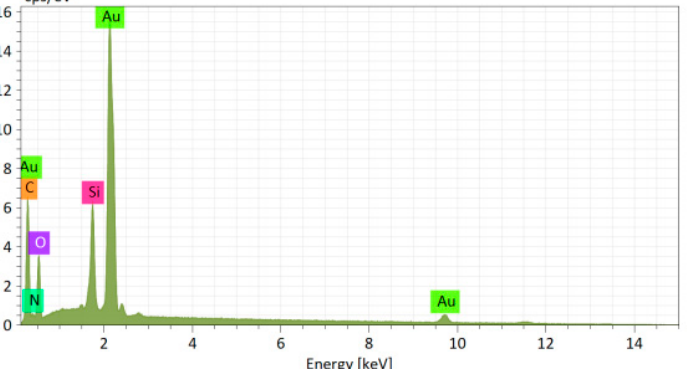
Figure 6. Energy dispersive X-ray spectrum from AuAcMTX: C—58.5 at. %; O—20.1 at. %; N—7.0 at. %; Au—8.4 at. %.